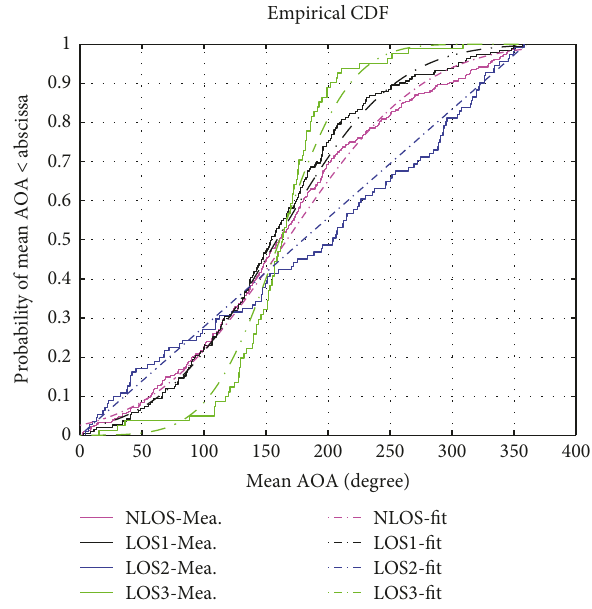
Figure 9: CDF for mean AOA in tunnel